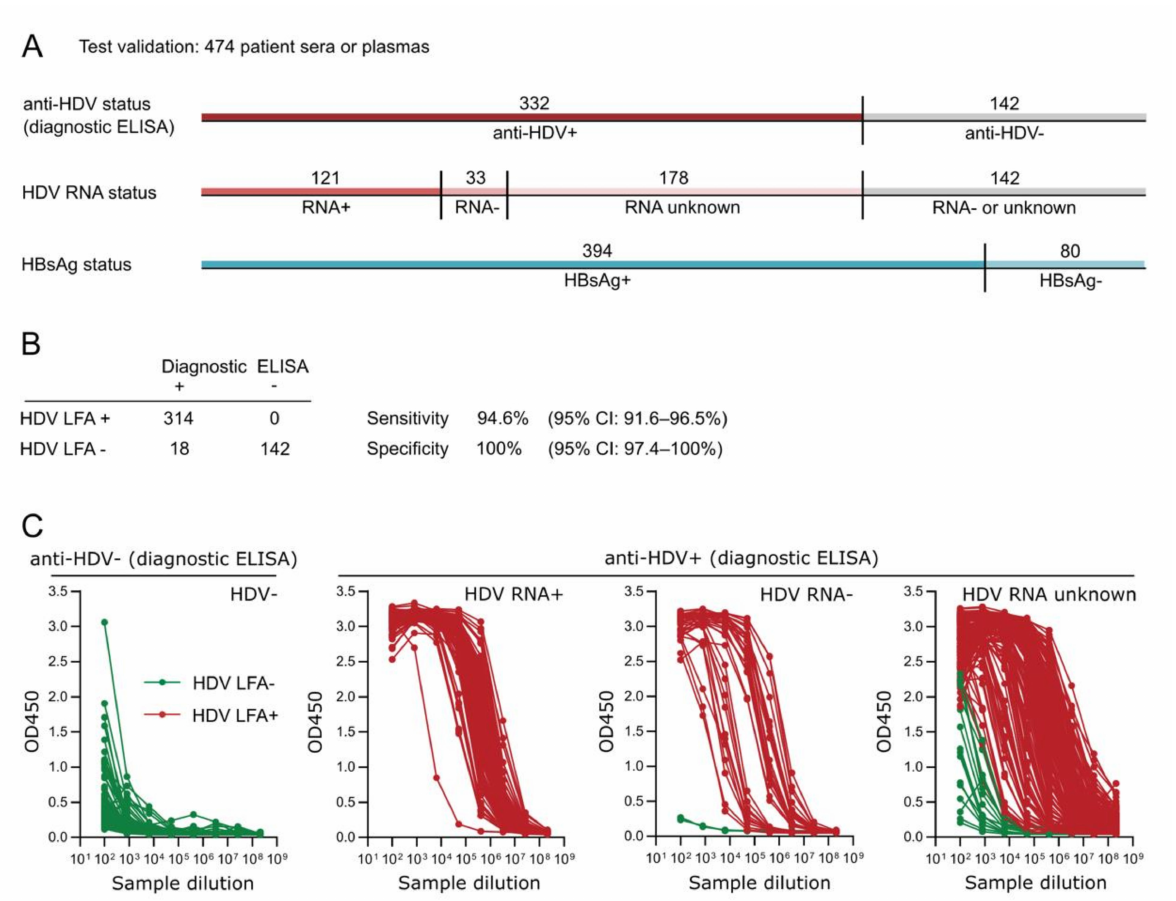
Figure 3. Test validation of the HDV rapid test. ( A ) Characterization of test validation sera or plasmas according to their pre-known anti-HDV status (ETI-AB-DELTAK-2 anti-HDV ELISA, DiaSorin, Saluggia, Italy or HDV Ab assay, Diapro Diagnostic Bioprobes, Sesto San Giovanni, Italy), HDV RNA status, and HBsAg status. Patient sera were collected from clinical and commercial vendors, including the University Hospital Heidelberg and the Heidelberg blood bank (Heidelberg, Germany), the Hanover Medical University (Hanover, Germany), the University of Ankara Medical School (Ankara, Turkey), and BIOMEX (Heidelberg, Germany). ( B ) Sensitivity and specificity of the HDV rapid test compared to the gold-standard ELISA. ( C ) Semi-quantification of anti-HDV in all 474 patient sera using an in-house ELISA. All sera were previously tested positive or negative for anti-HDV using a commercial gold-standard ELISA. The same samples were tested for anti-HDV using the HDV rapid test. Qualitative HDV rapid test results (positive: green; negative: red) are overlaid with the semi-quantitative in-house ELISA